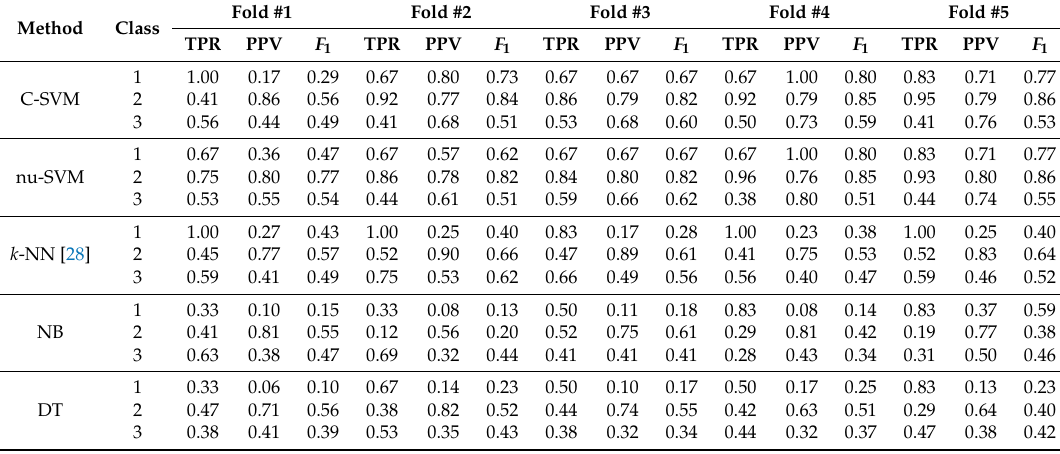
Table 5. Five-fold cross-validation results of the five benchmark methods when the